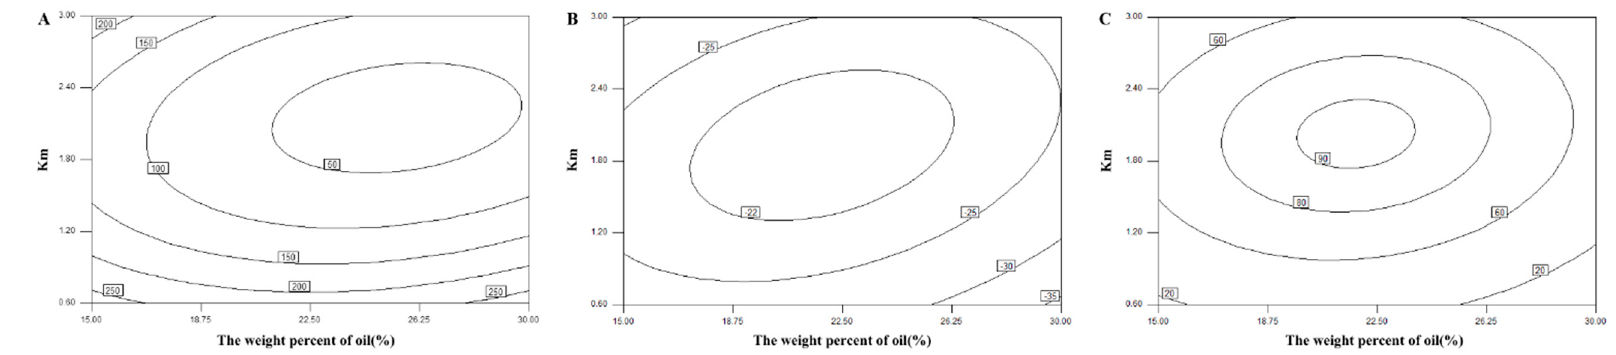
Figure 2. Response surface plot (3D) of droplet size ( A ); zeta potential ( B ); and percent drug dissolution efficiency after 20 min ( C ).